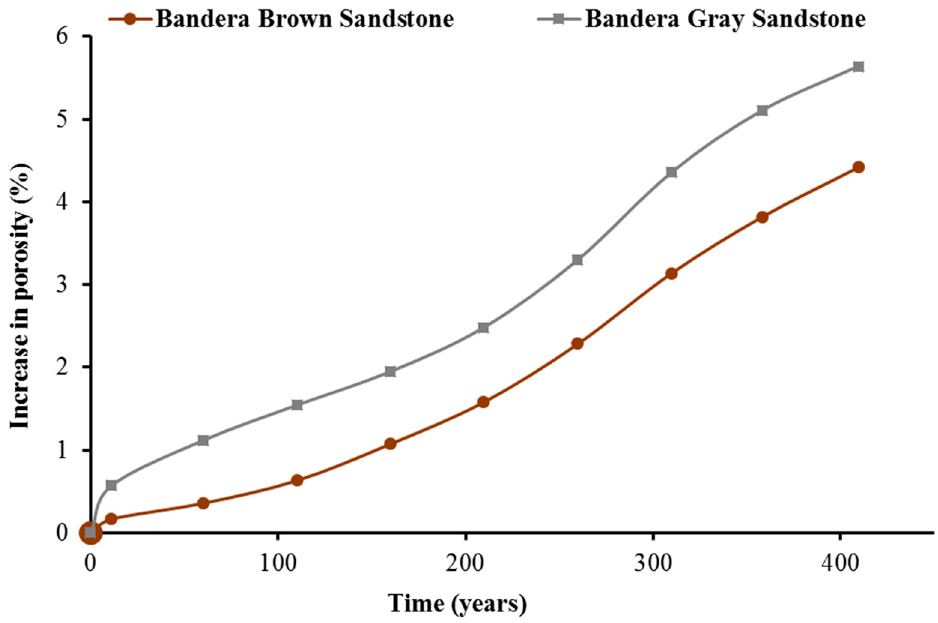
Figure 6. Porosity variations for the high and low clay-content sandstones with storage time.